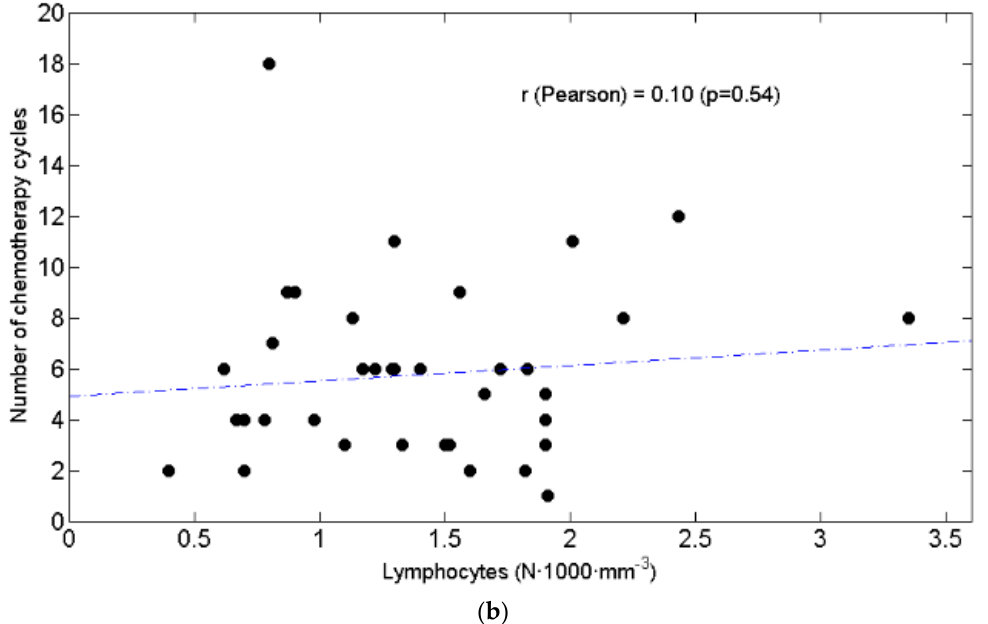
Figure 1. Scatter plots of the number of chemotherapy cycles (y axis) as a function of circulating lymphocytes (x axis) expressed as percentage of total white blood cells ( a ) and as absolute value ( b ). The value of Pearson’s correlation coefficient and corresponding p value are also reported. TWBC: total white blood cells. Figure 2. Mortality rate varies in relation to circulating lymphocytes expressed as percentage of Total White Blood Cells.